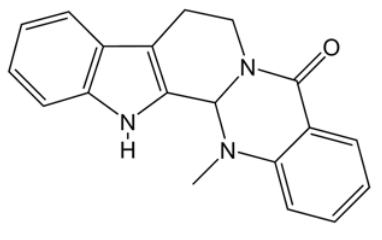
Figure 1. Chemical structure of